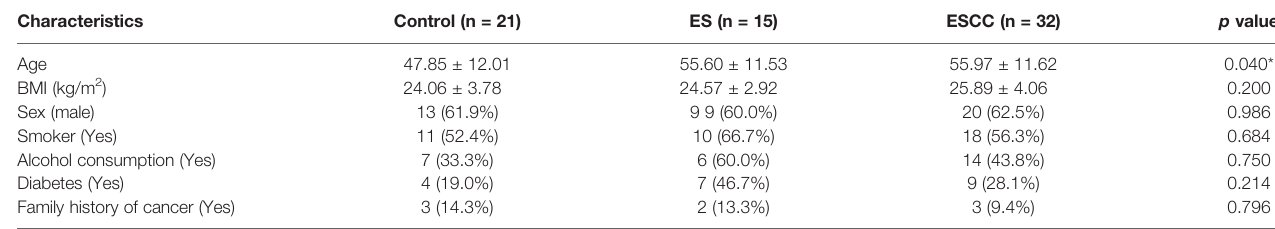
TABLE 1 | Clinical characteristics of enrolled patients and healthy controls.